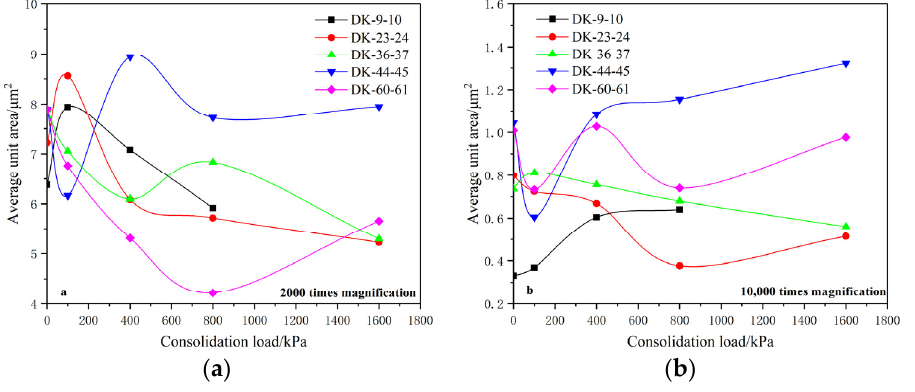
Figure 6. Relationship between the average unit area and the consolidation load. ( a ) 2000 times magnification; ( b ) 10,000 times magnification.